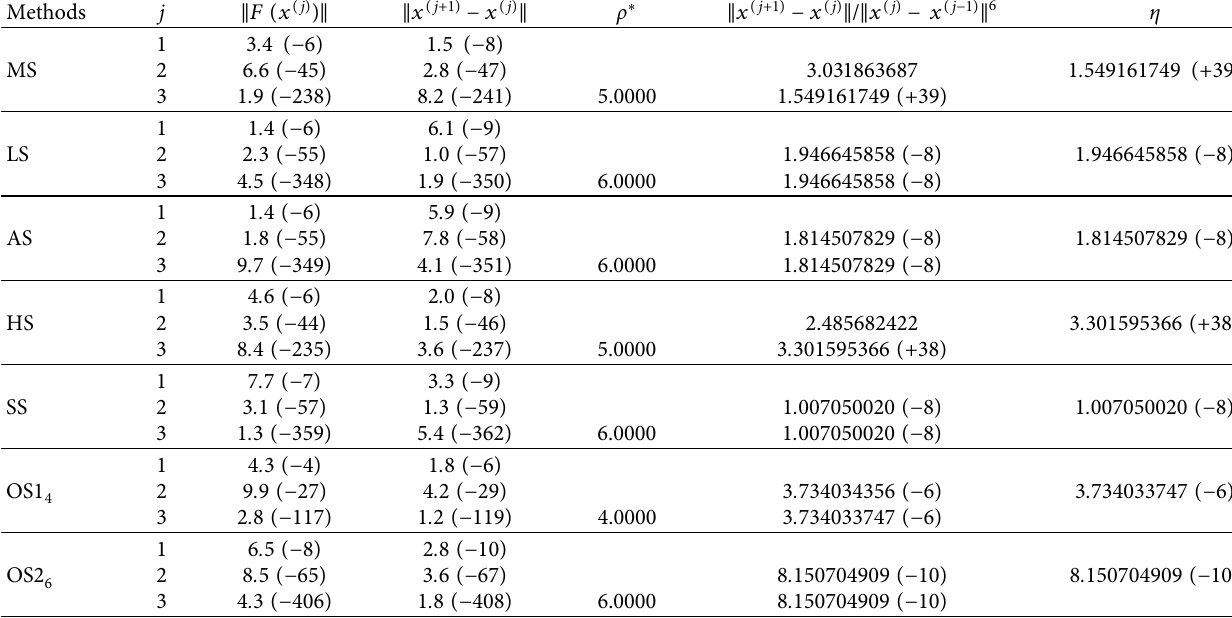
Table 5: Convergence behavior of different methods on example 5.